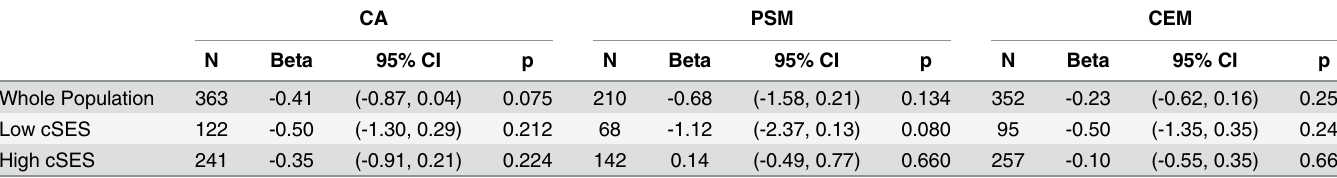
Table 8. Results from CA, PSM, and CEM methodologies for number of depressive symptoms.